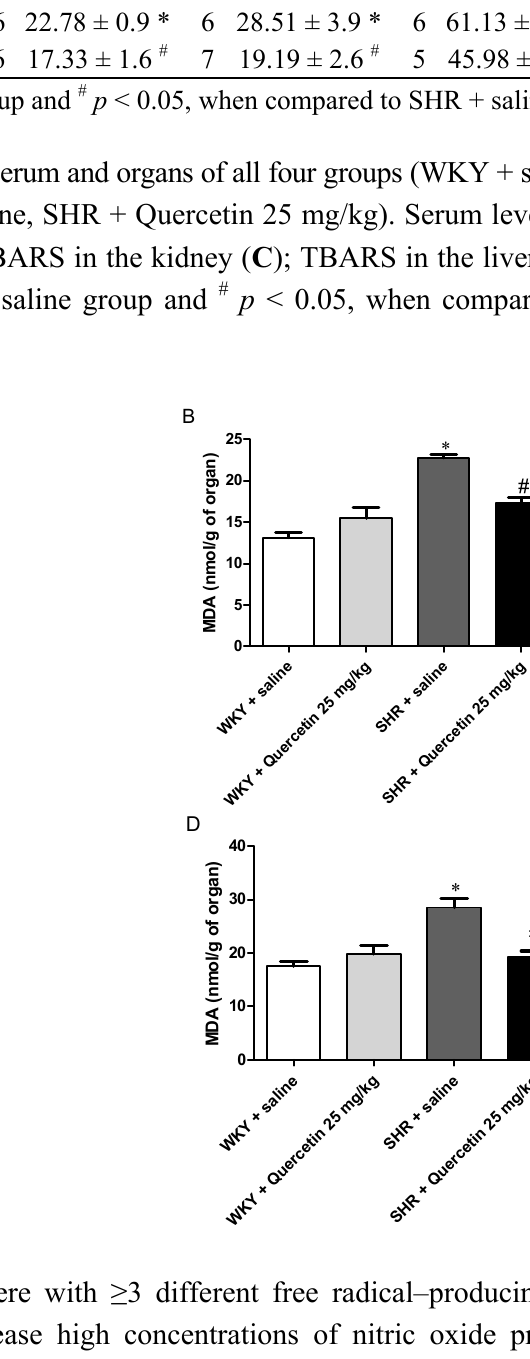
Table 1. Determination of oxidative stress using the thiobarbituric acid-reactive substances (TBARS) assay in organs and serum of all four groups (WKY + saline, WKY + Quercetin 25 mg/kg; SHR + saline, SHR + Quercetin 25 mg/kg). WKY + Saline 1.6 ± 1.1 9 13.13 ± 1.5 7 17.5 ± 2.1